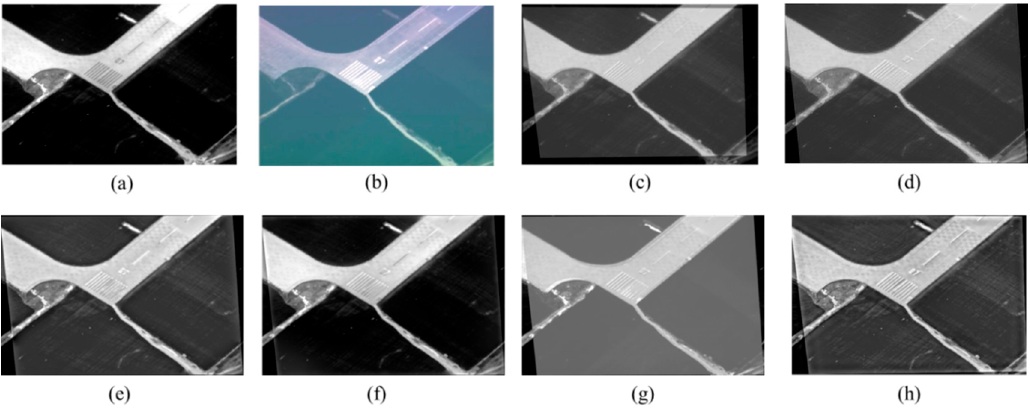
Figure 8. Airport image fusion comparisons: ( a ) IR image; ( b ) Visible image; ( c ) Registered image; ( d )